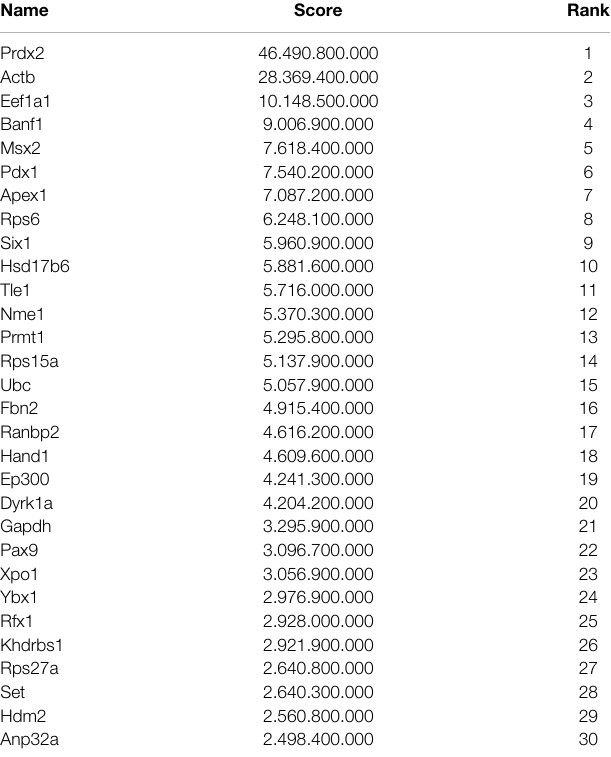
TABLE 2 | Important synovial sarcoma nodes identi fi ed with Cystoscape. Nodes found to be hubs (important nodes with numerous edges) and close expression neighbors of ctag1b/a with the gene set enrichment (GSEA) module analysis method are shown in red. Prdx2 is highlighted yellow as the top- ranked